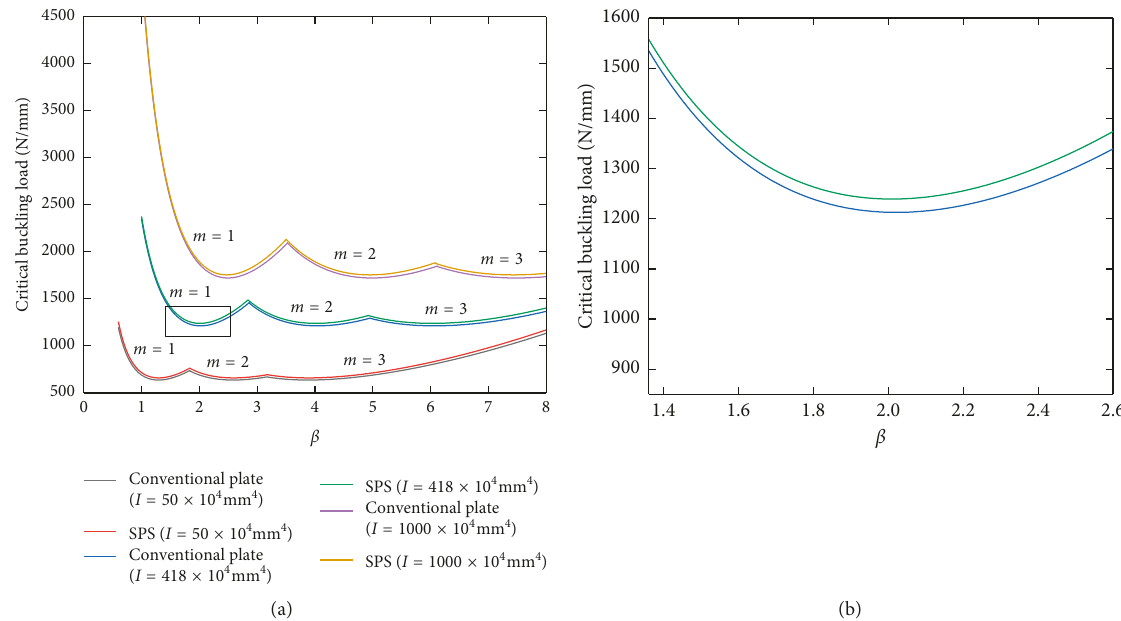
Figure 8: Relation between β and critical buckling load for different inertia moments of a single rib on the SPS and steel plates. (a) Original relations between β and critical buckling loads. (b) Local enlargement of the curves in (a).